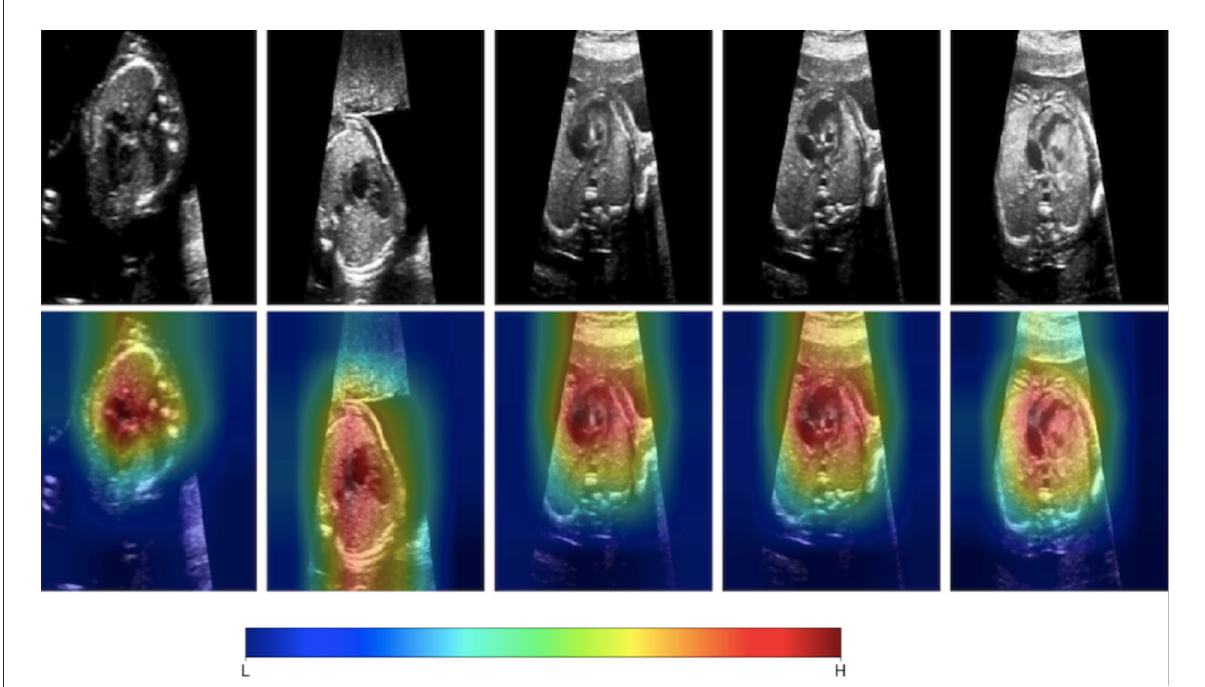
FIGURE2 Gradient-weighted class activation mapping (Grad-CAM) helps us understand what aspects of an image are important in a deep learning model’s decision-making. Chotzoglou et al. developed a DL model that classified fetal images as normal or abnormal cardiac anatomy. They used Grad-CAM mapping to demonstrate that the model identifies cardiac structures as important in understanding if the fetal ultrasound image represents a normal or abnormal heart. Figure adapted from Chotzoglou et al.